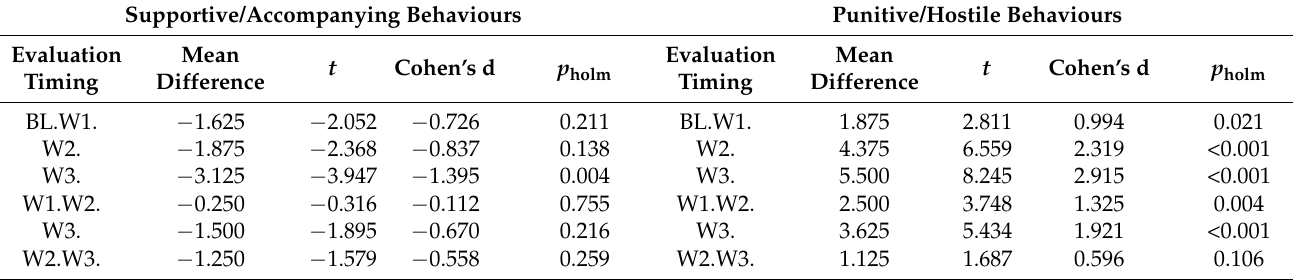
Table 9. Effect size of the programme in family interactions for intervention group.